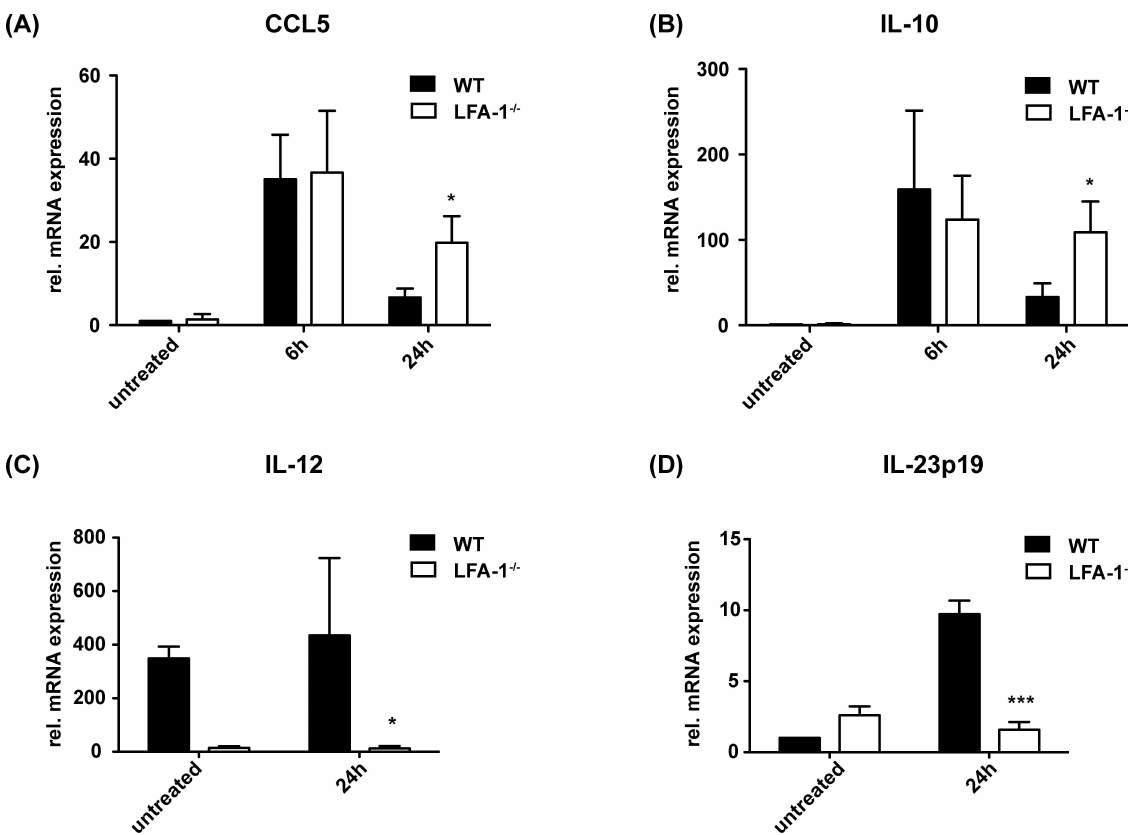
Fig 5. The cytokine milieu in liver parenchyma after PH and low-dose LPS. PH in presenceof 50 μ gLPS per 20g body weight was performed in WT and LFA-1 -/- mice and amount of CCL5 (A), IL-10 (B), IL-12 (C) or IL-23p19 (D) cytokine/chemokine-specific mRNA was analyzedby qRT-PCR. The amount of cytokine/chemokine-specific mRNA in the liver tissue of the untreatedWT mice was definedas standard value 1. Mean ± SD from 4 mice is depicted.Significancesrefer to the comparisonof the WT and LFA-1 -/- mice and were tested by two-way